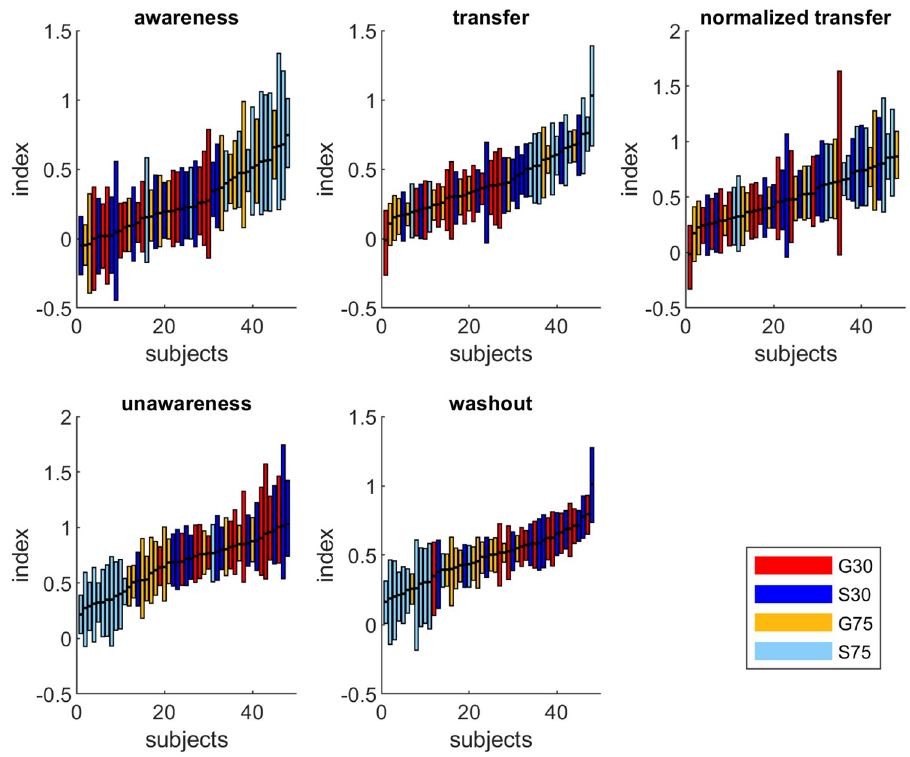
Fig 5. Individual subjects performance for awareness, unawareness, intermanual transfer and washout. Each line represents one subject and the range of the line is the HDI for that individual. Subjects are sorted by their mean score and coloured according to their